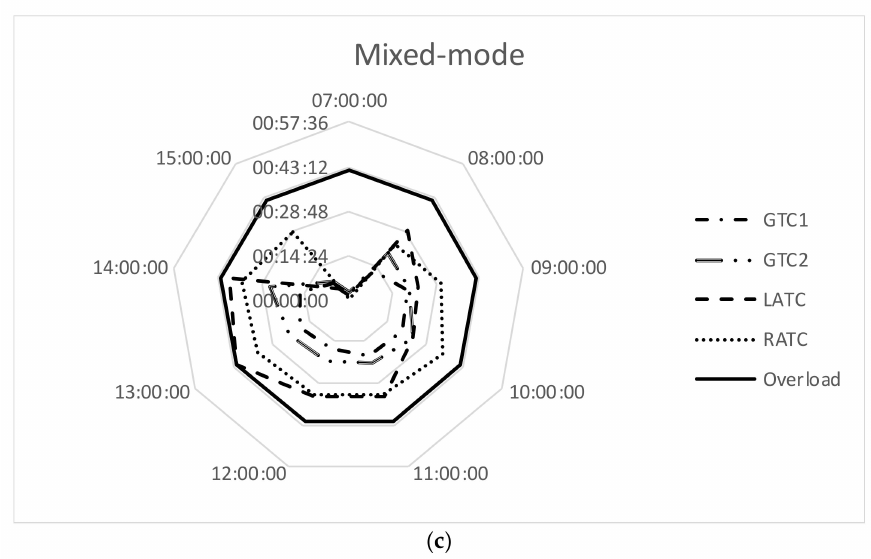
Figure 6. Workload of controllers when 2 GTCs are available: ( a ) hub-in; ( b ) hub-out; ( c )